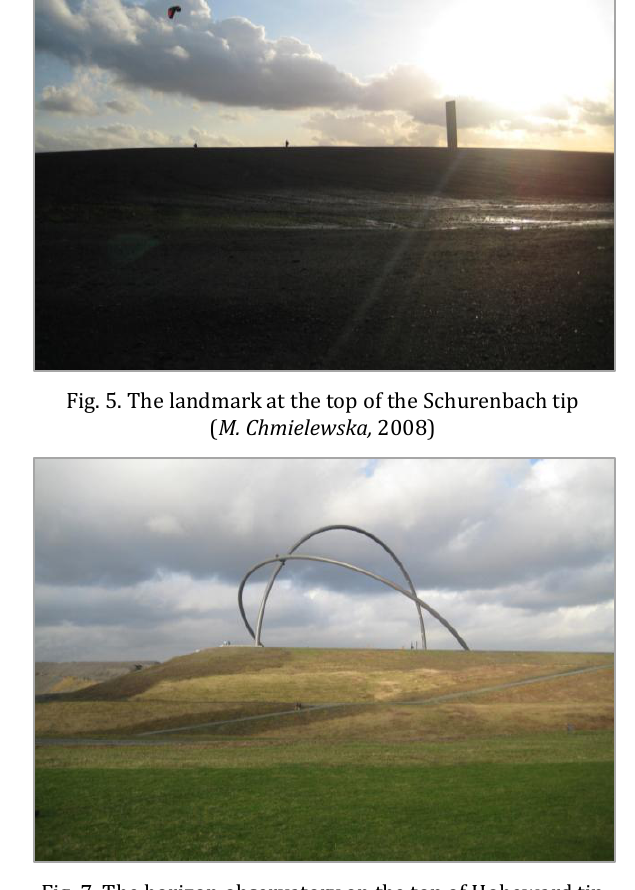
Fig. 7. The horizon observatory on the top of Hoheward tip Fig. 8. A mine spoil tip in Nordstern Landscape